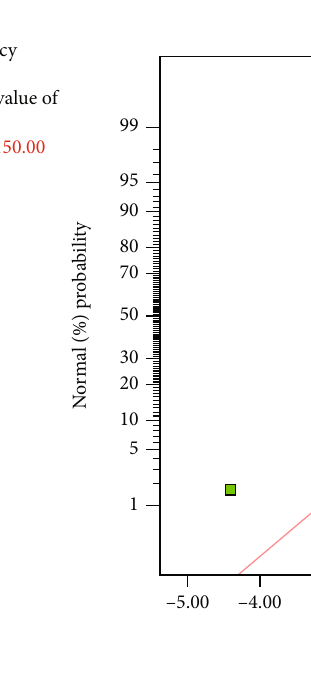
Figure 6: Normal probability plots of the residuals for CEX adsorption on Fe